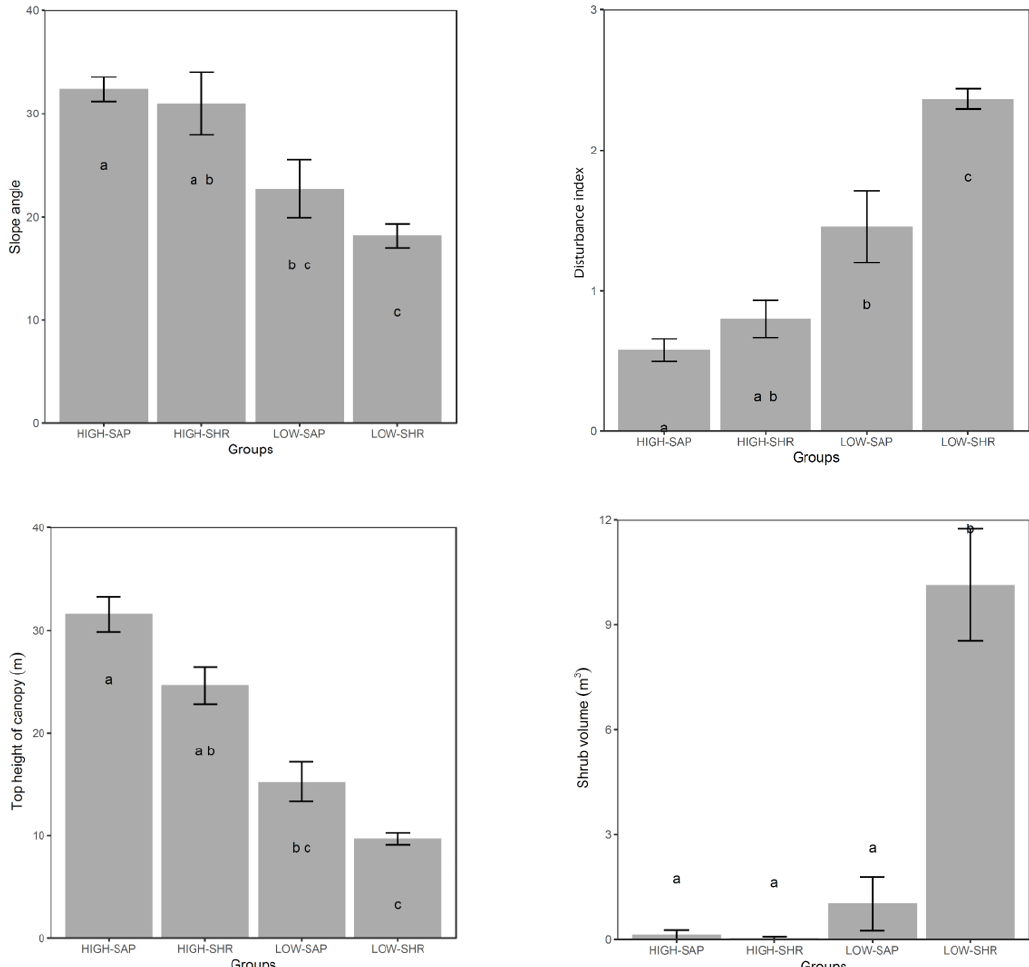
Figure 5. Selected forest stand and environmental variables averaged for the five habitat clusters. Letters indicate groups that do not signifi- cantly differ (Kruskal–Wallis nonparametric test, p value < 0 . 05). Error bars are ± SE. Table 2. Ordered logit model showing the relationship between selected environmental variables and the final reconfiguration of four woody plant groups across six sacred forests (HIGH-SAP, HIGH-SHR, LOW-SAP, LOW-SHR). The numbers in parentheses represent the different levels of the ordinal categorical variables.